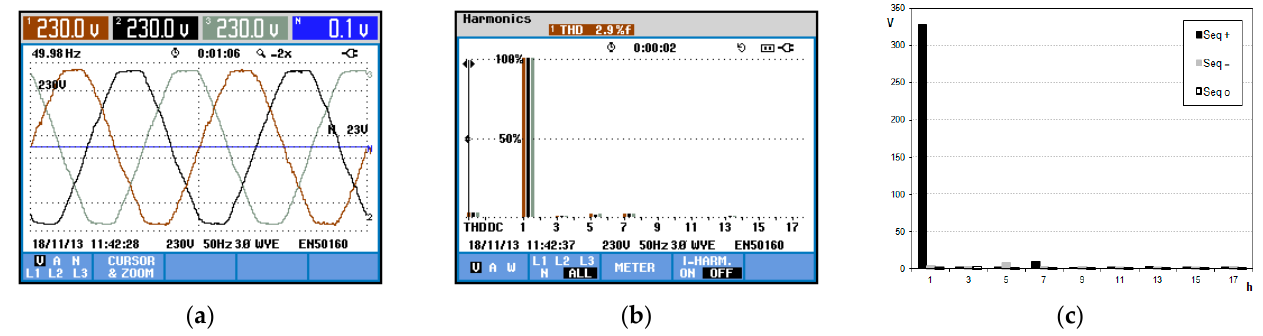
Figure 44. Case 6 - four-wire ShAPF operating with unbalanced loads: ( a ) three-phase voltages; ( b ) harmonic spectrum of the voltages; ( c ) harmonic spectrum of the voltage sequence components (maximum values).